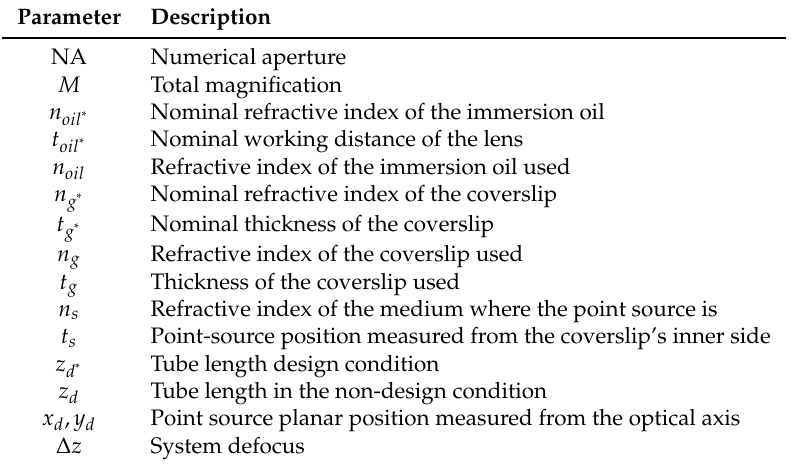
Table 1. Gibson and Lanni model parameters and their